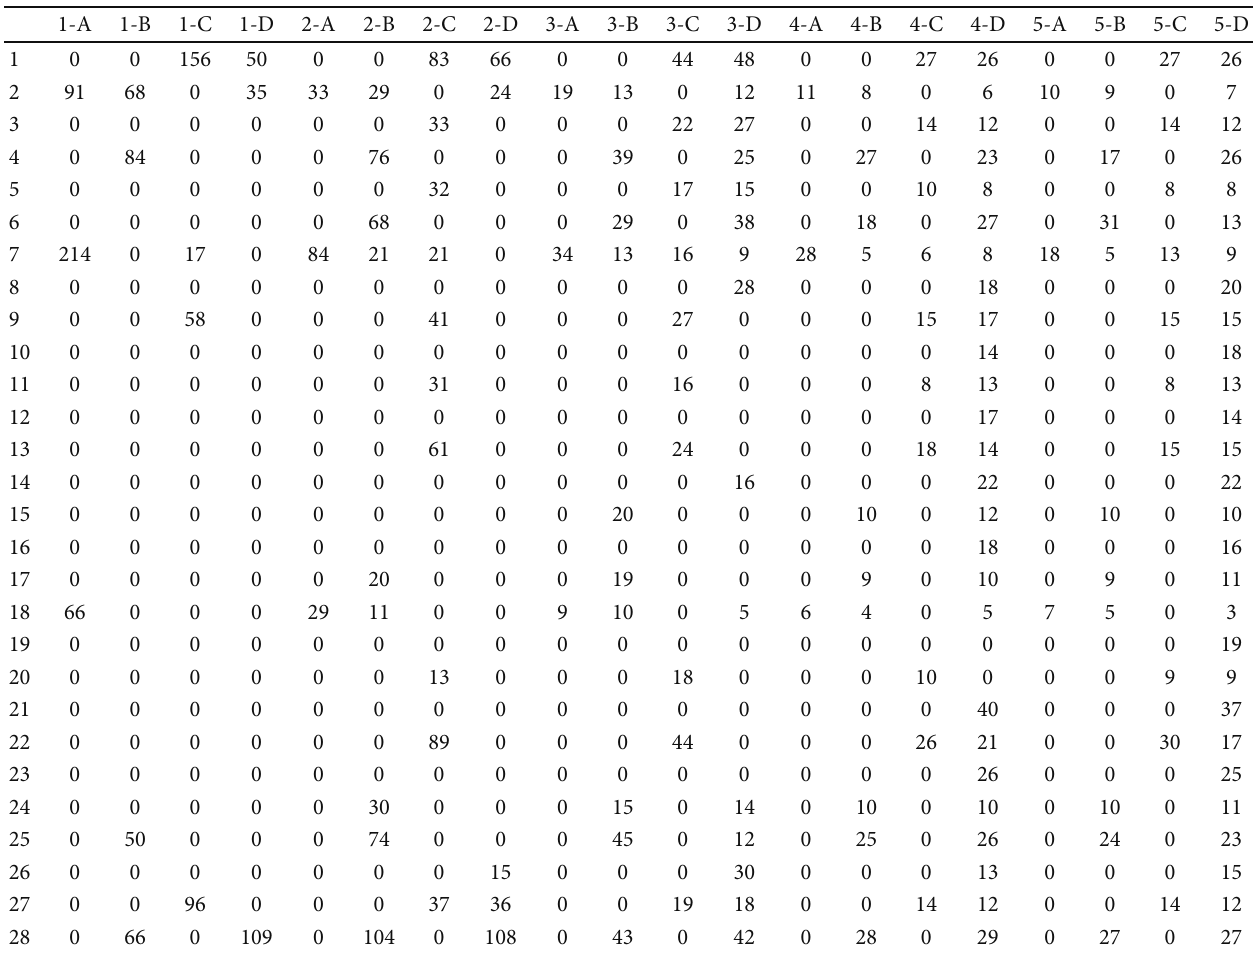
Table 4: Ticket allocation scheme for con fi dence level α = 0 : 9 .